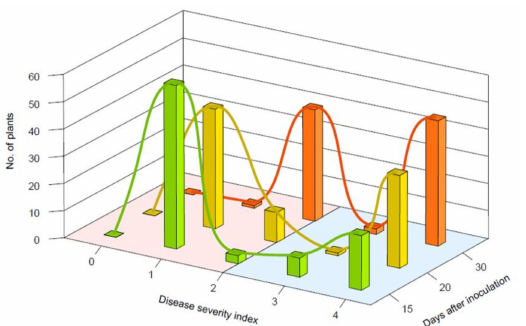
Figure 6. Histograms and curve graphs represented the number of plants’ phenotype segregation based on disease severity scores of the F 2 population ( n = 90) at 15 (green bar), 20 (yellow bar), and 30 dai (orange bar). The plants were inoculated with R. solanacearum strain SL1931, the bacterial suspensions are 1 × 10 6 CFU/mL to give inoculum volume of 0.1 mL/leaf at fully expended 3rd and 4th leaf stages in a plant. The red zone and blue zone represent resistance and susceptible,